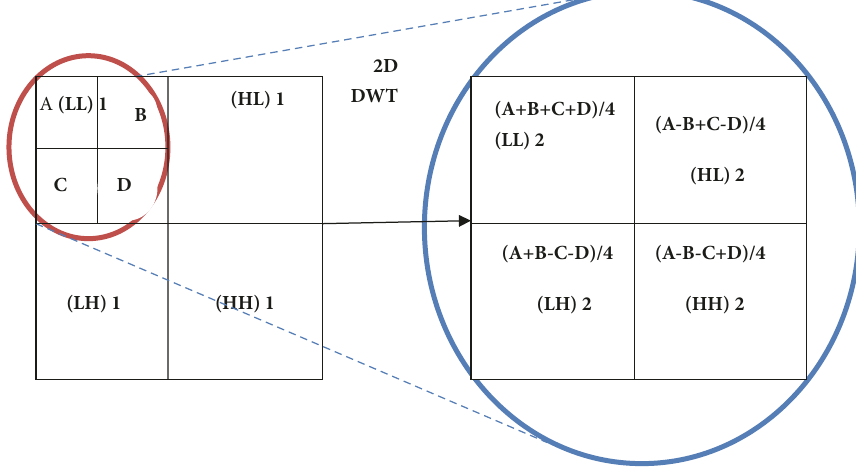
Figure 3: New values of an image after one level DWT decomposition.